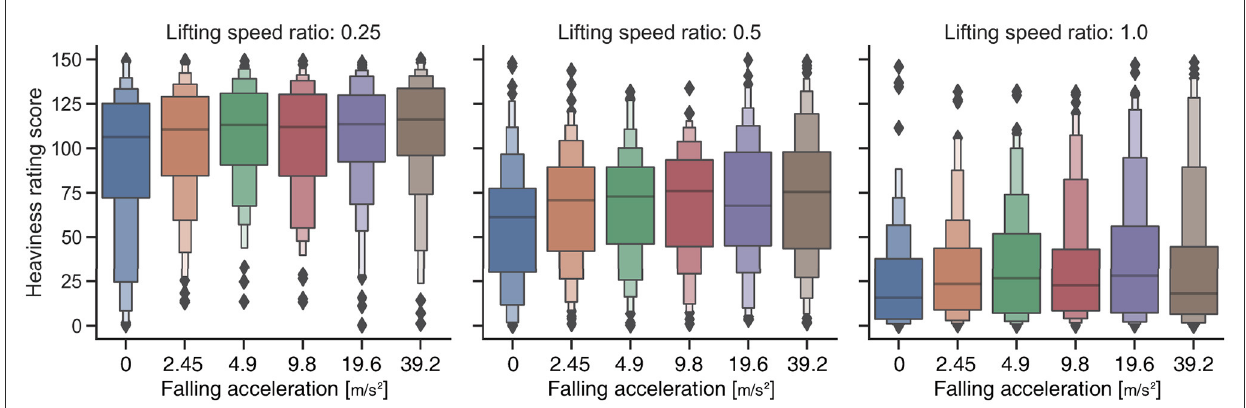
FIGURE3 Heaviness rating score for each combination of lifting speed ratio and falling acceleration. The y-axis corresponds to the visual analog scale (VAS) presented to participants. The smallest value of the VAS is 0 (corresponding to “I don’t feel heaviness at all”) and the largest value of the VAS is 150 (corresponding to “I feel the heaviest feeling I can